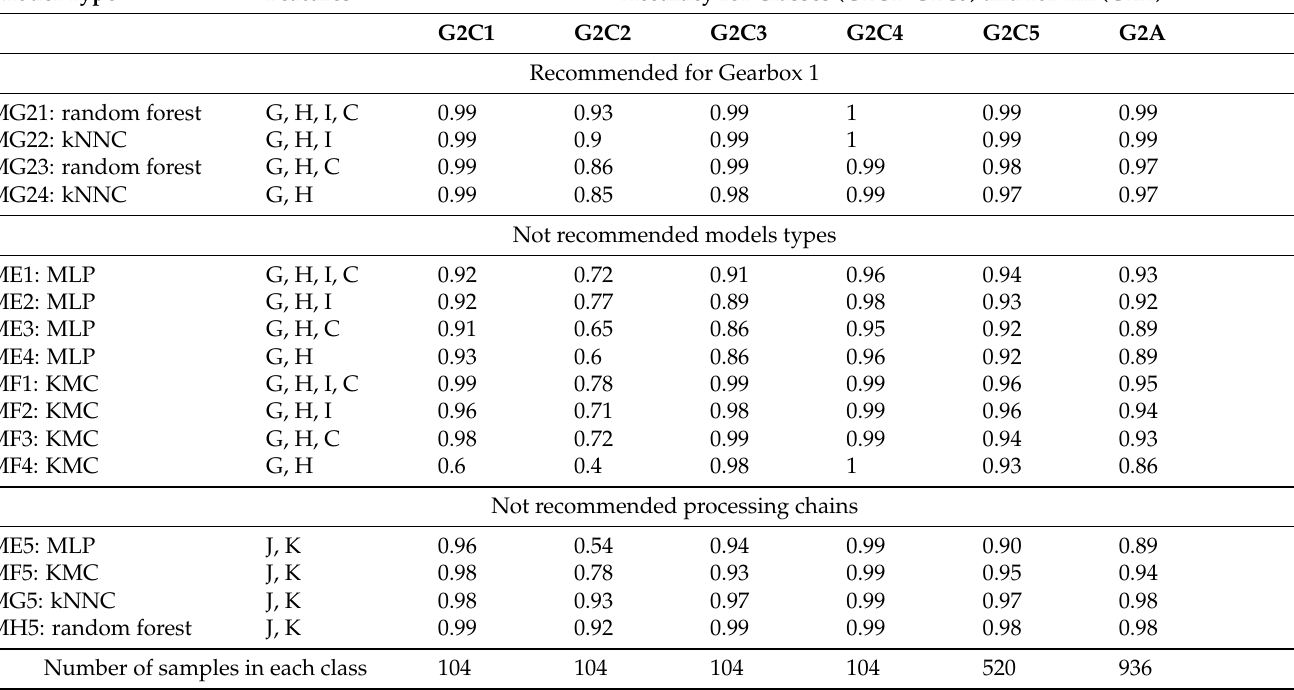
Table 8. Model accuracy for Gearbox